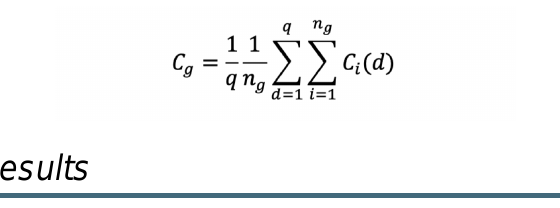
Figure 6. Average compliance of each group for each version.